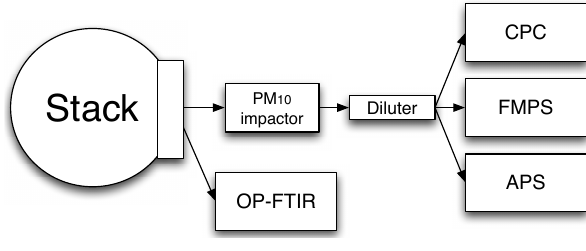
Fig. 2. Schematic of measurement